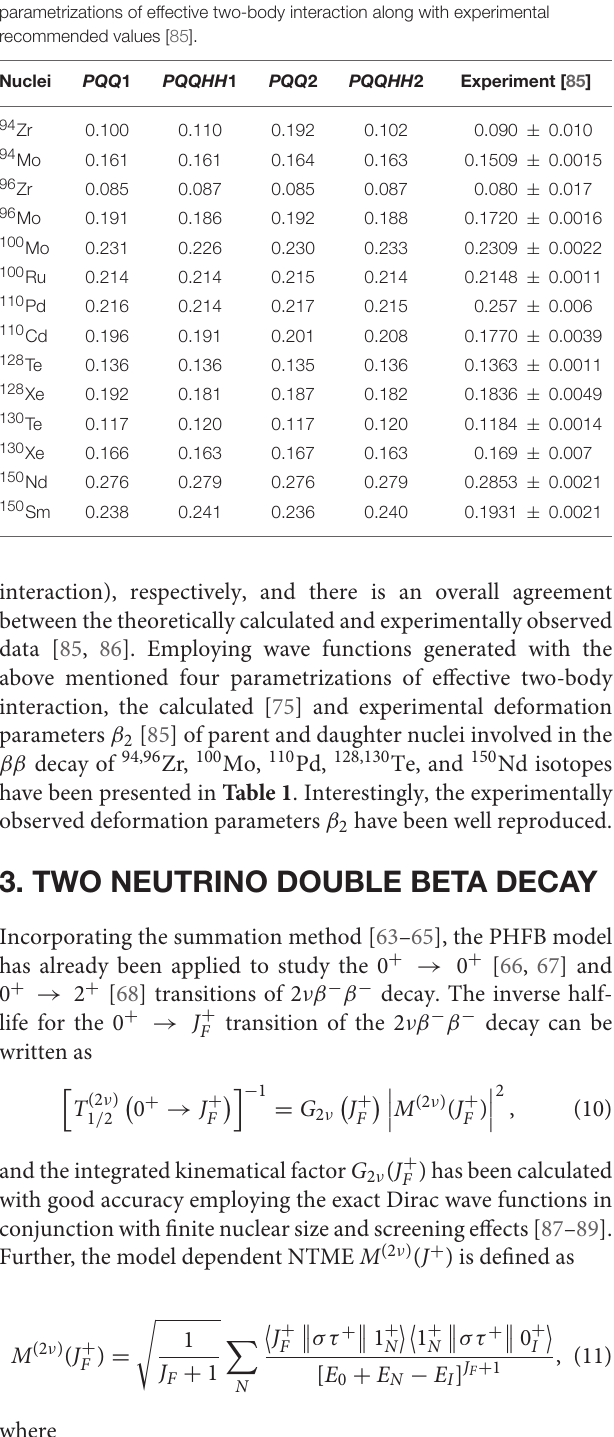
over intermediate states using the summation method [63–65], the NTME M (2 ν ) ( J + ) is written F